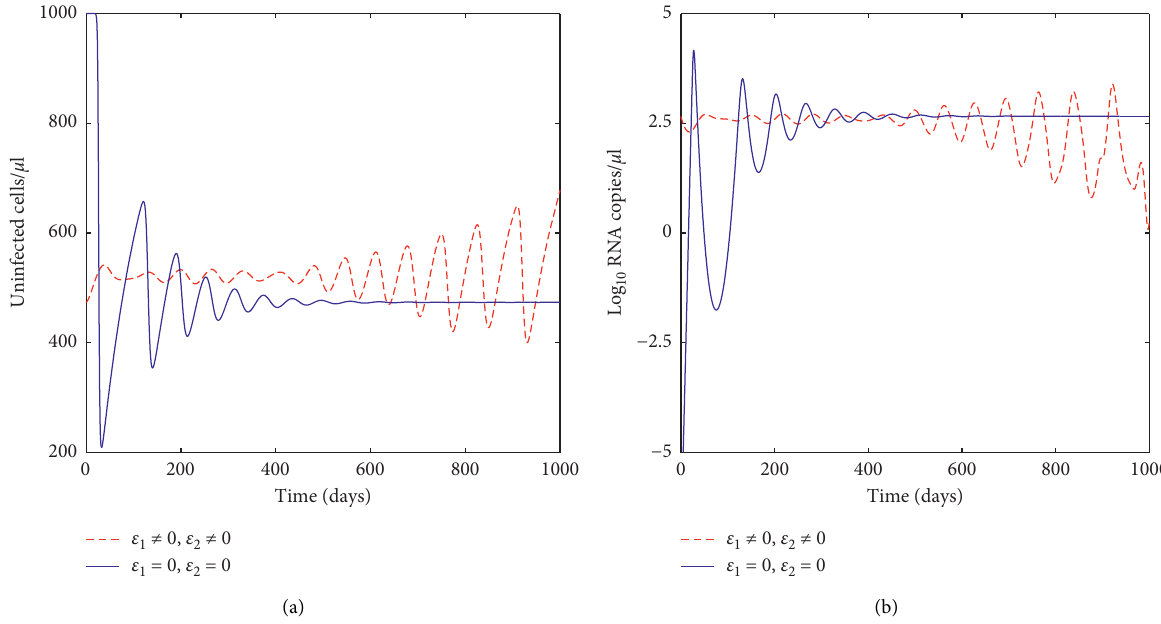
Figure 13: The level of (a) uninfected cells and (b) viral load corresponding to the optimal control strategy with ε are without control and dashed lines are with control, in which r